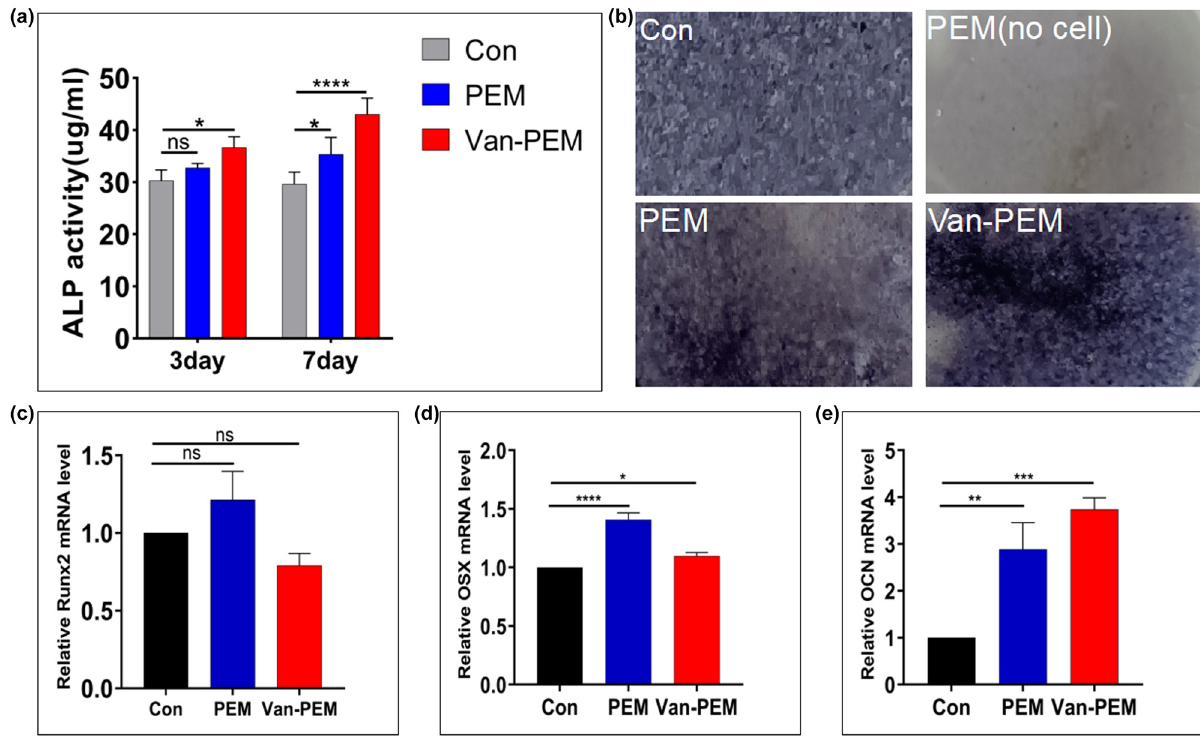
Figure 6: ( a ) Secretion of ALP by osteoblasts in the PEM and Van - PEM hydrogels. PEM and Van - PEM hydrogels can promote the secretion of ALP from osteoblasts. ( b ) ALP staining of osteoblasts cultured in the PEM and Van - PEM hydrogels for 7 days. ( c – e ) Expression of osteogenic genes Runx2, OSX, and OCN detected by RT - PCR in osteoblasts cultured in PEM and Van - PEM hydrogels for 14 days. Van - PEM hydrogels can signi fi cantly promote the expression of